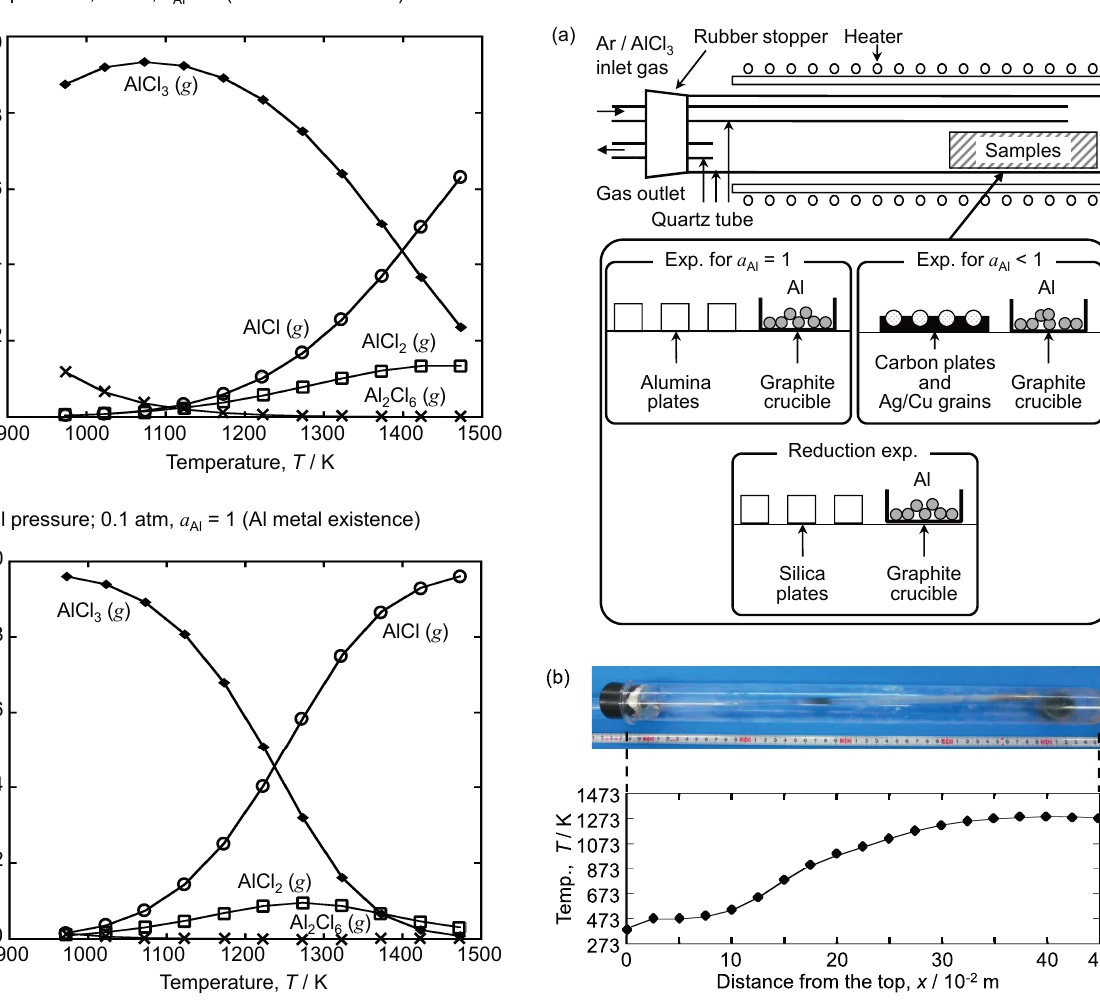
Figure 4. (a) Schematic illustration and (b) temperature distribution of the experimental setup used in this